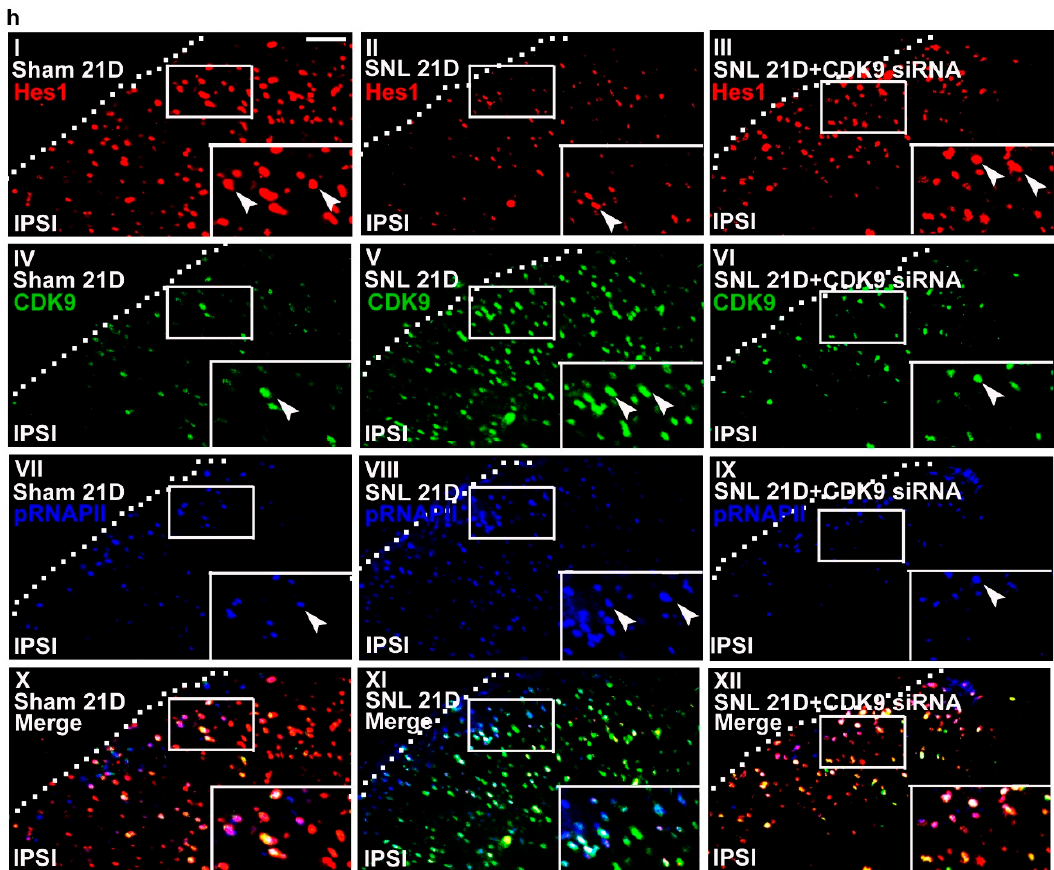
Figure 6. Neuropathic injury induces allodynia with reciprocal changes in spinal Hes1 ‐ CDK9 levels. ( a ) Representative Western blot and statistical analyses (normalized to GAPDH) of the dorsal horn sample dissected from naïve animals (Naïve) at day 4 after the start of treatment. The abundance of CDK9 was not affected by implantation of an intrathecal catheter alone (it) or spinal administration of polyethylenimine (PEI, 10 μ L; daily for 4 days) or missense siRNA (MS siRNA, 5 μ g, 10 μ L; daily for 4 days) but was dose ‐ dependently decreased by intrathecal administration of CDK9 siRNA (CDK9 siRNA; 1, 3, and 5 μ g; 10 μ L; daily for 4 days). IB, Immunoblotting. One ‐ way ANOVA, post ‐ hoc Tukey test, F (6,35) = 10.16, p < 0.0001. ** p < 0.01 vs. Naïve. n = 6. ( b ) Rota ‐ rod test demonstrating no statistical difference in the motor performance among naïve animals as well as naïve animals administered with polyethylenimine, missense siRNA, or CDK9 siRNA (5 μ g, 10 μ L). The gray bar at the bottom indicates the duration of the reagents’ administration. n = 7. Two ‐ way ANOVA with repeated measures over time, treatment, F (3,24) = 0.4792, p = 0.6997; time, F (4,96) = 0.2094, p = 0.9351; treatment × time, F (12,96) = 1.123, p = 0.3510. ( c , d ) Von Frey test demonstrating that while it exhibited no effect on the sham ‐ operated group, spinal administration of CDK9 siRNA (5 μ g, 10 μ L), but not missense siRNA or polyethylenimine, increased the withdrawal threshold of the ipsilateral hind paw of SNL rats at days 19, 20, and 21 after operation. The gray bar at the bottom indicates the duration of the reagents’ administration. * p < 0.05, ** p < 0.01 vs. SNL. n = 7. Sham, Two ‐ way ANOVA with repeated measures over time, treatment, F (3,24) = 0.2648, p = 0.8501; time, F (4,96) = 0.4465, p = 0.7747; treatment × time, F(12,96) = 0.3796, p = 0.9679. SNL, Two ‐ way ANOVA with repeated measures over time, treatment, F (3,24) = 32.28, p < 0.0001; time, F(4,96) = 7.267, p < 0.0001; treatment × time, F(12,96) = 5.291, p < 0.0001. ( e , f ) RT ‐ PCR and western blot analyses (normalized to GAPDH) of ipsilateral dorsal horn samples dissected at day 21 post operation. When compared with the sham operation (Sham 21D), SNL (SNL 21D) increased the abundance of mGluR5 mRNA as well as CDK9, phosphorylated RNAPII (pRNAPII), and mGluR5 protein but decreased that of Hes1 protein. These effects were all reversed by administering SNL animals with CDK9 siRNA (SNL 21D + CDK9 siRNA) but not the missense siRNA (SNL 21D + MS siRNA). mGluR5 mRNA, one ‐ way ANOVA, post ‐ hoc Tukey test, F